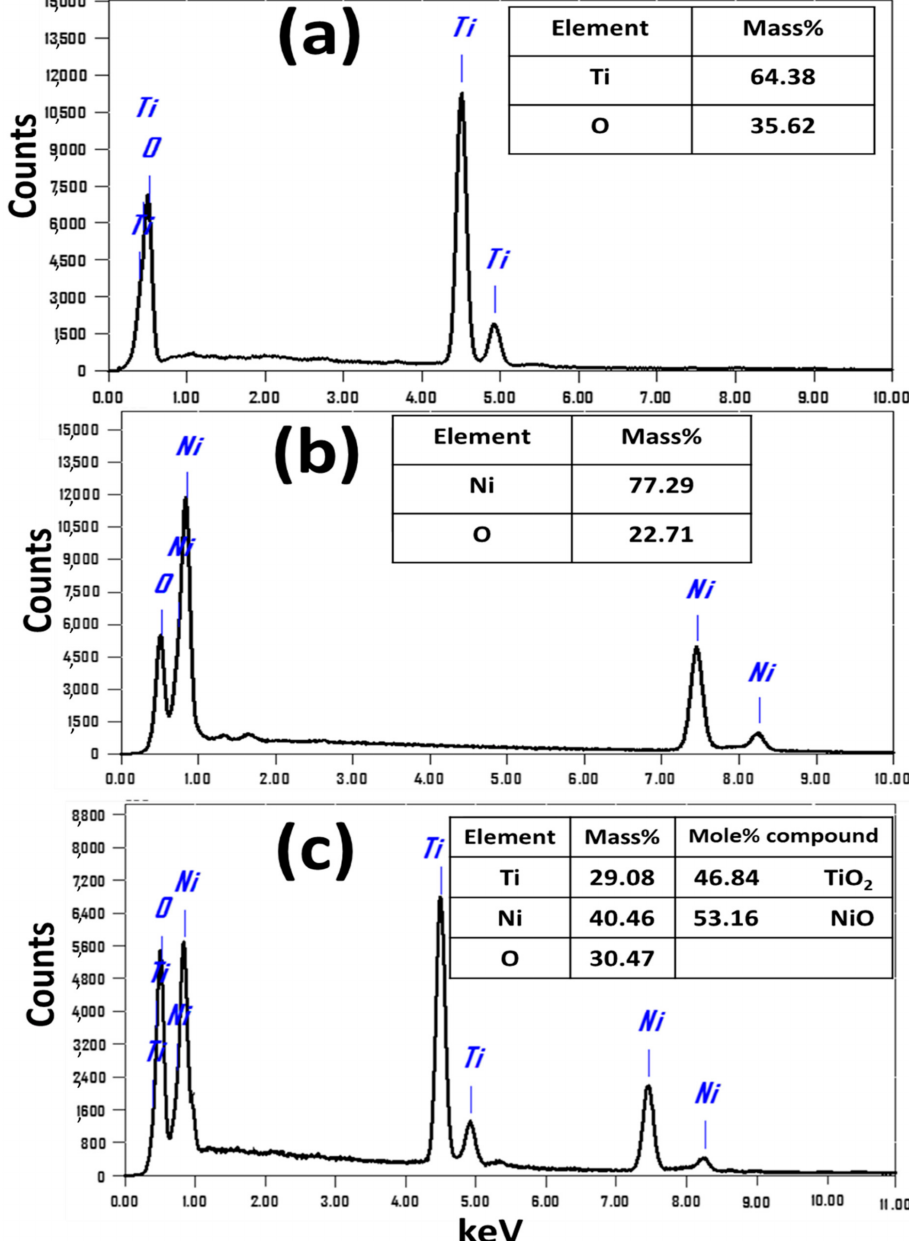
Figure 3. EDX spectra for ( a ) TiO 2 NTs, ( b ) TiO 2 /2NiO, and ( c ) NiO NPs. The inset Tables show the quantitative EDX